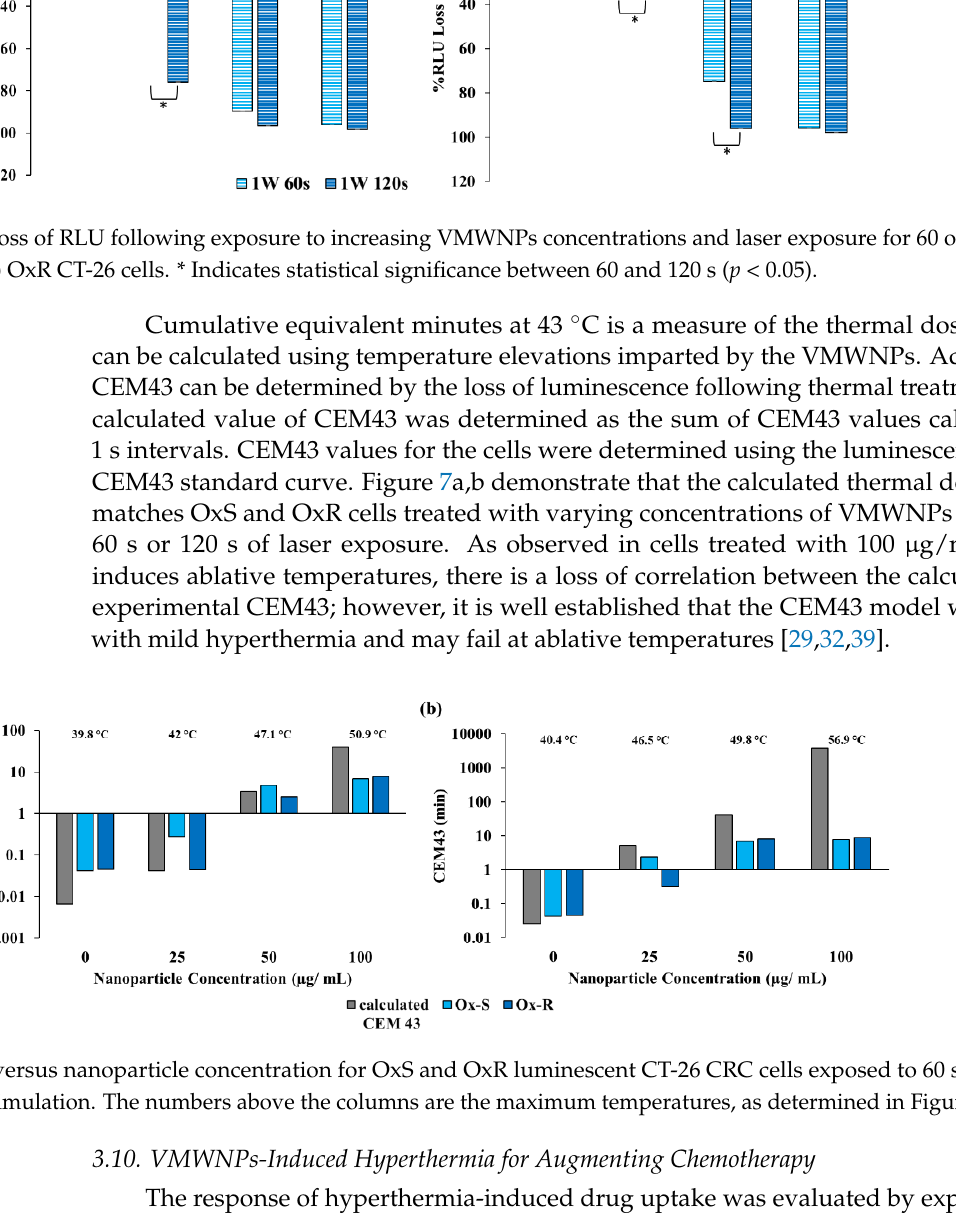
Figure 7. CEM43 versus nanoparticle concentration for OxS and OxR luminescent CT-26 CRC cells exposed to 60 s ( a ) or 120 s ( b ) of laser stimulation. The numbers above the columns are the maximum temperatures, as determined in Figure